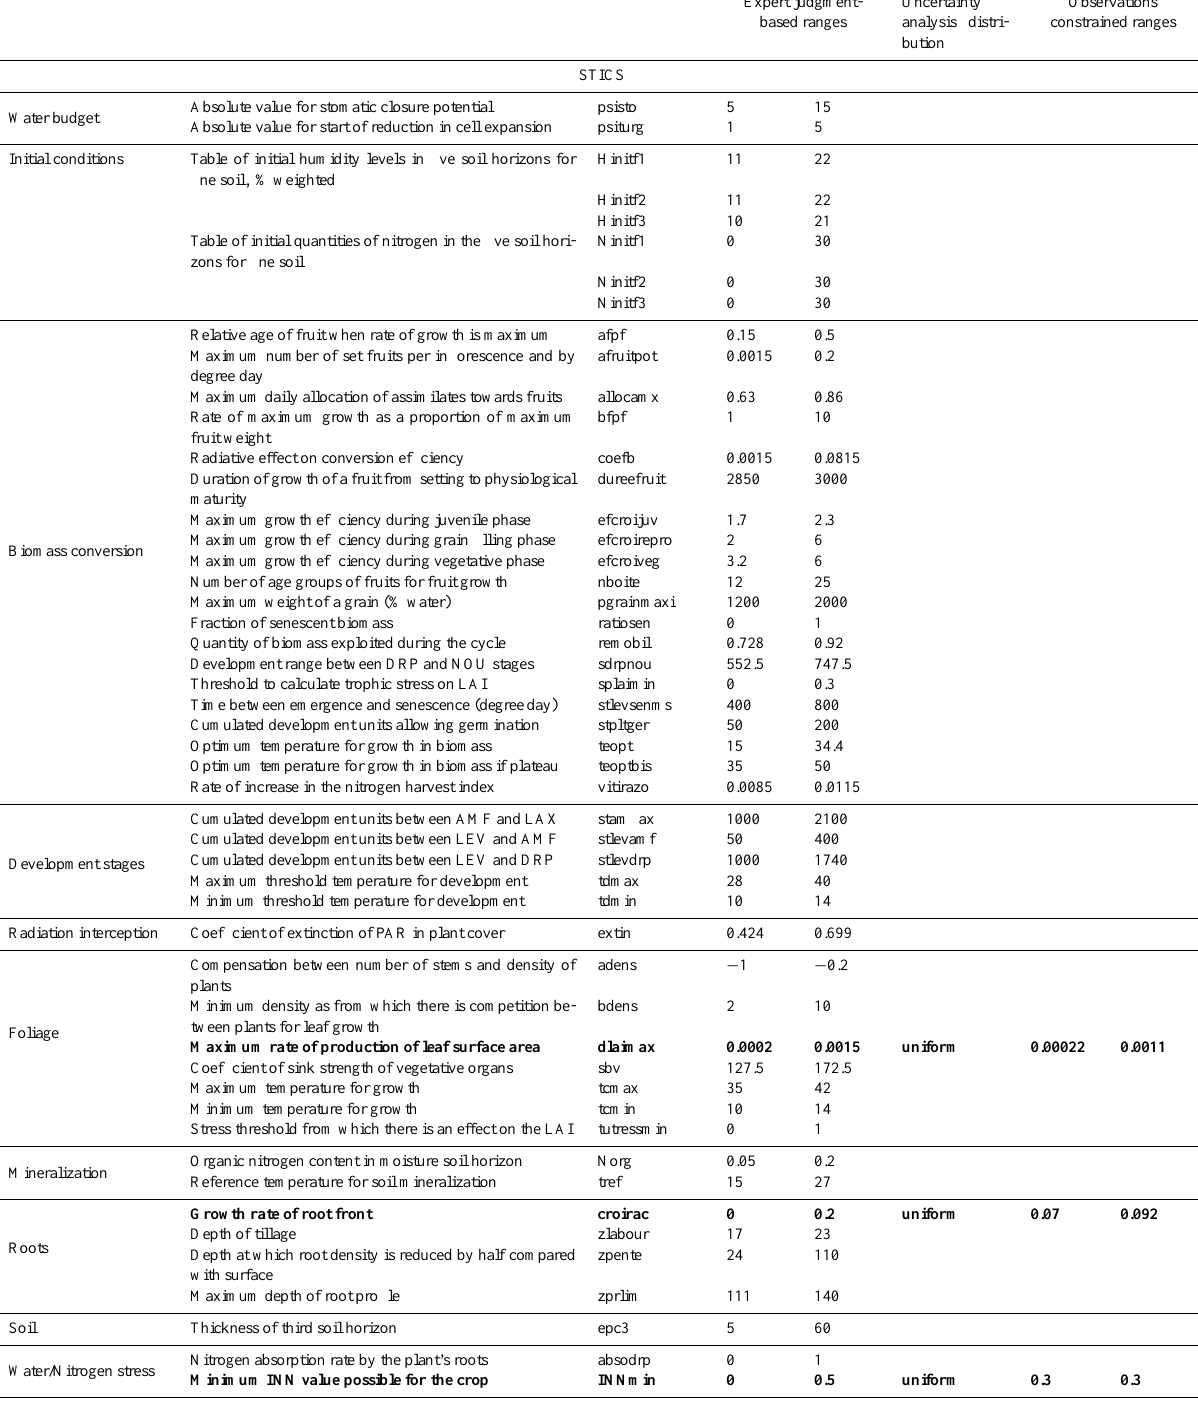
Table 2. List of parameters from STICS and ORCHIDEE included in each step of the analysis with their ranges of variation. Parameters in bold indicate parameters identified by the screening analysis as the most important for uncertainty propagation.